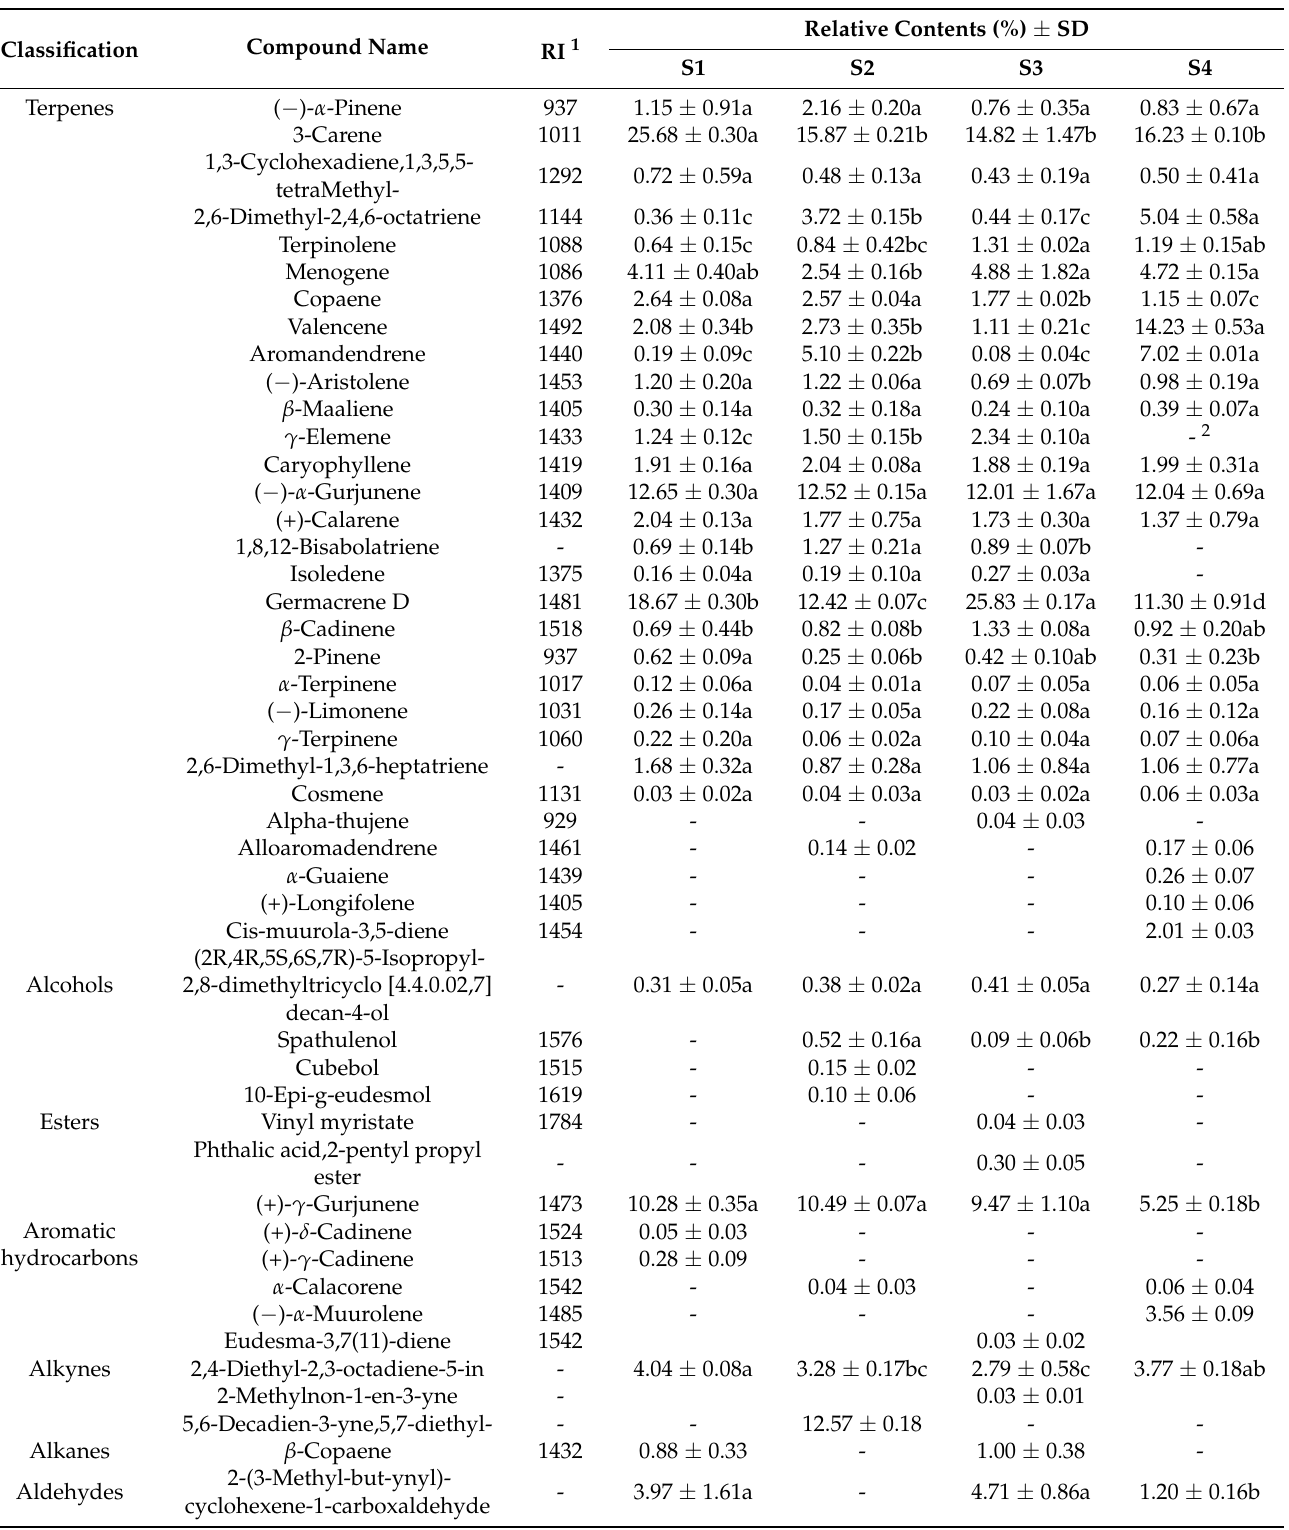
Table 2. Relative contents of floral fragrance compounds in the flowers of different P. notoginseng